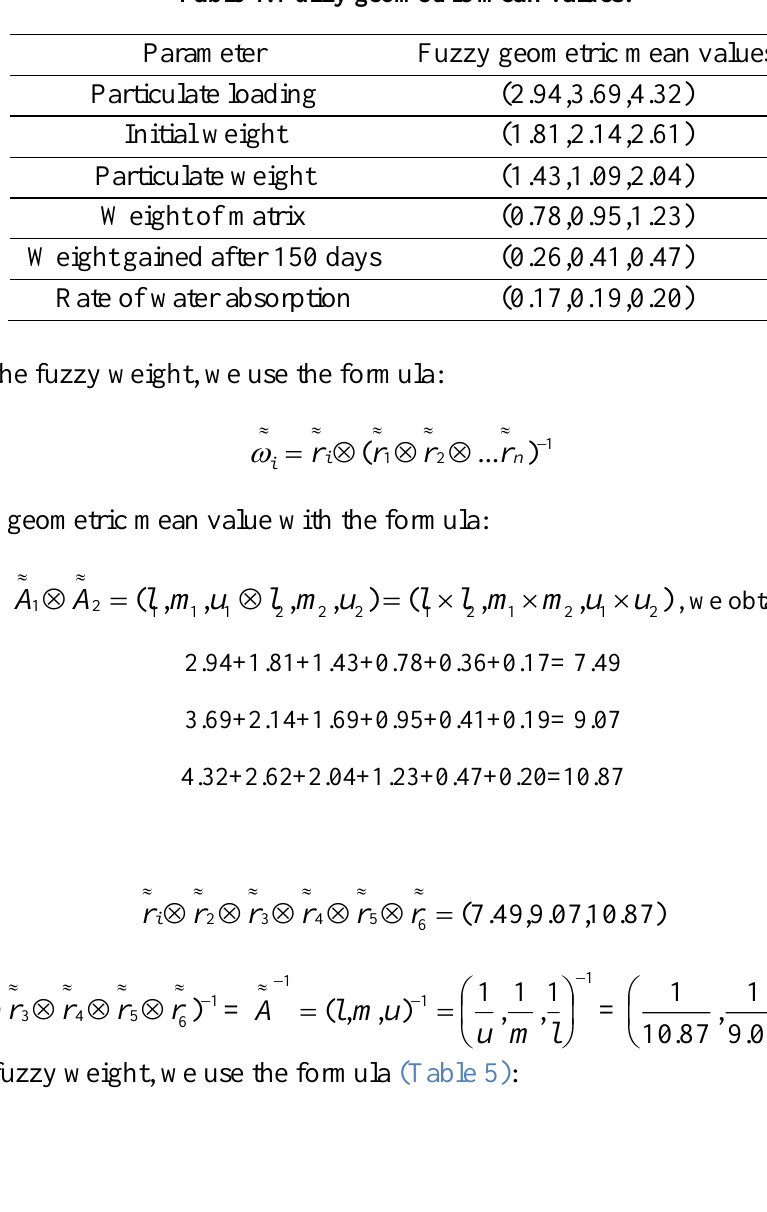
Table 4. Fuzzy geometric mean